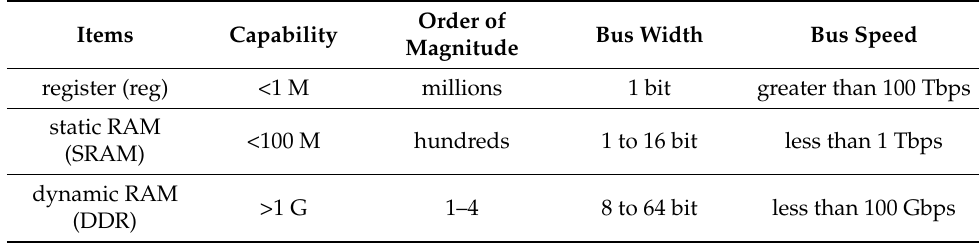
Table 3. FPGA storage